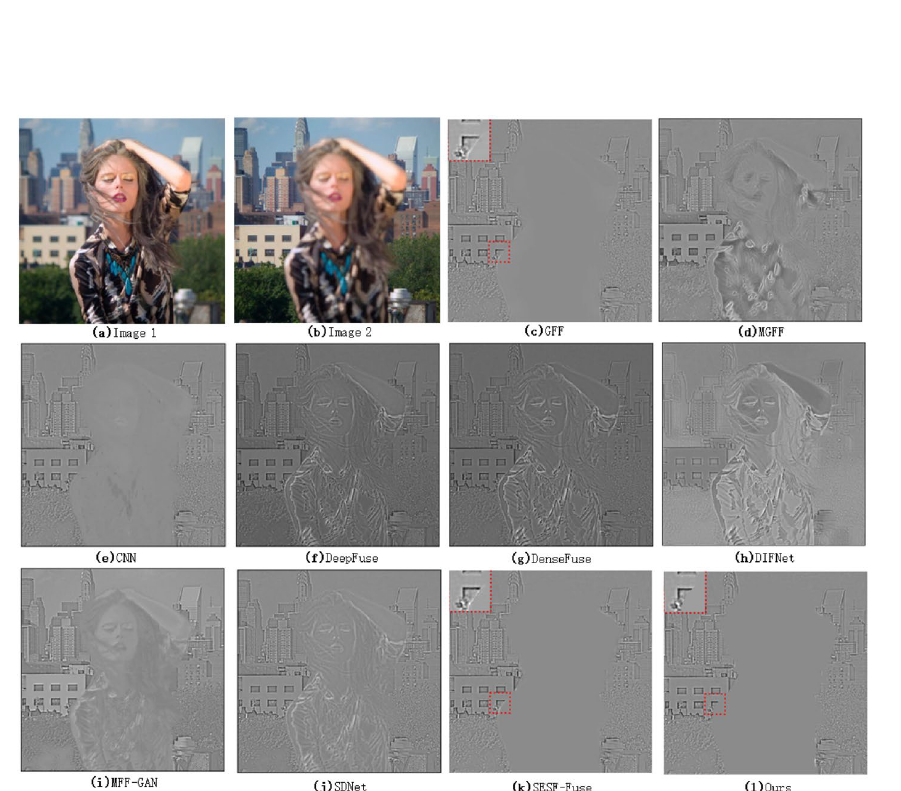
Figure 5. Comparison of difference between fused image and original image 1(Lytro 7 35